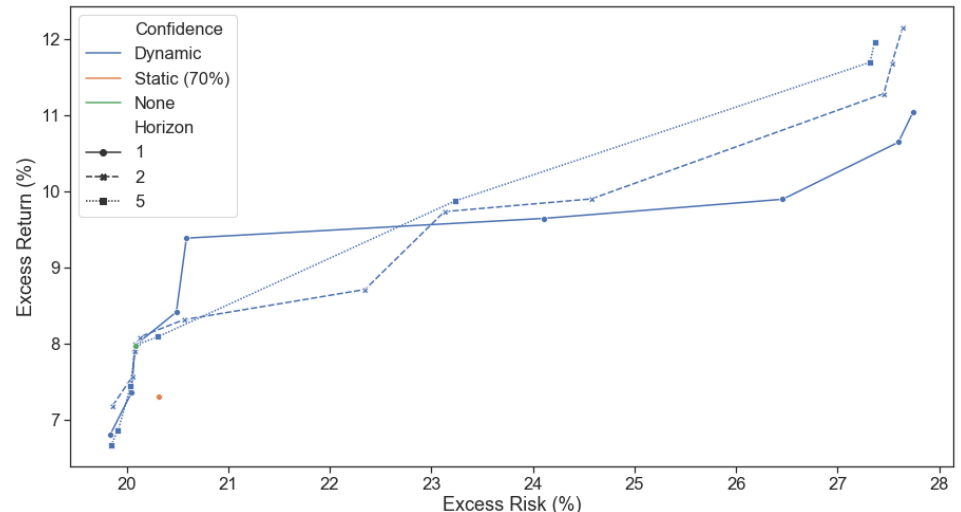
Figure 15. Short EWG and Long SPY View Performance